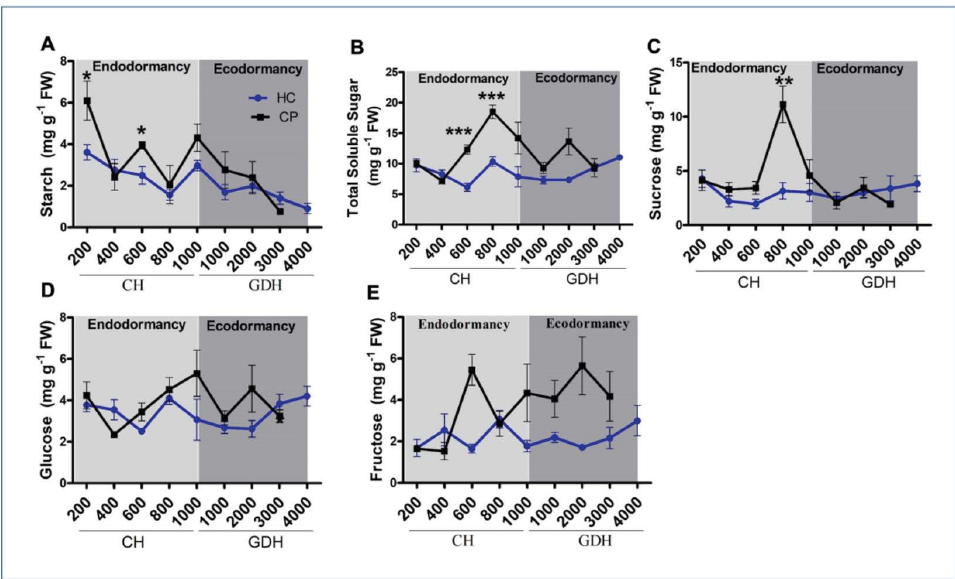
Figure 2. Starch ( A ), total soluble sugar ( B ), sucrose ( C ), glucose ( D ) and fructose ( E ) levels in two apple cultivars ‘Honeycrisp’ (HC) and ‘Cripps Pink’ (CP). Bud samples were collected from endodormancy induction to the bud break stage. The 200, 400, 600, 800, 1000 CH and 1000, 2000, 3000, and 4000 GDH corresponds to 11/11, 11/25, 12/05, 12/19, 1/10, 2/13, 03/04, 03/11, 03/17 dates in 2019–2020 respectively. Each point represents mean ± SEM of three biological replicates; p -value indicates comparison between ‘Honeycrisp’ and ‘Cripps Pink’ (* p < 0.05, ** p < 0.01, *** p < 0.001) using students t -test.